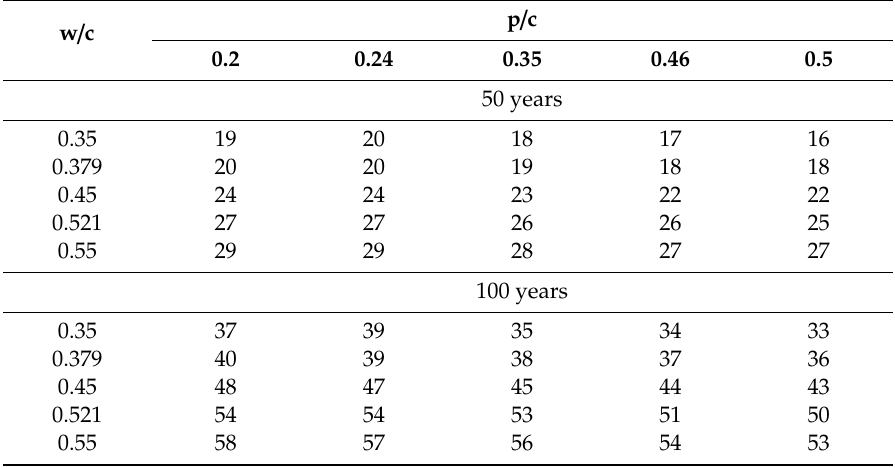
Table 10. Calculated depths of carbonation (mm) after 50 and 100 years in a natural atmosphere. w /